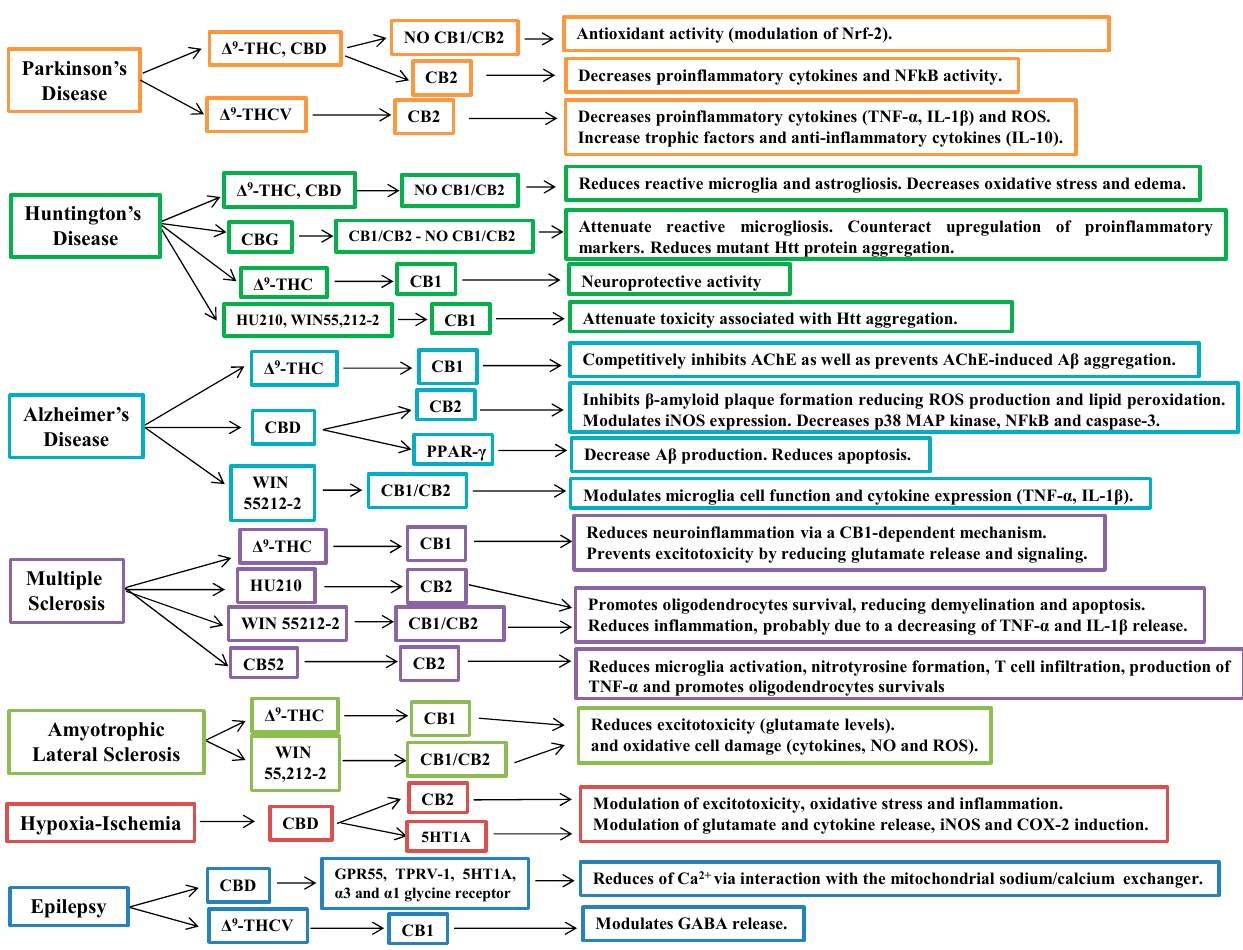
Figure 4. Cannabinoid-induced cellular signaling in neurologic